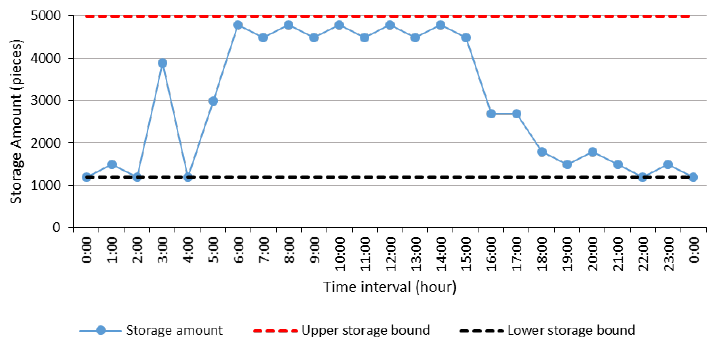
Figure 11. Storage amount of steel plate during each time interval.